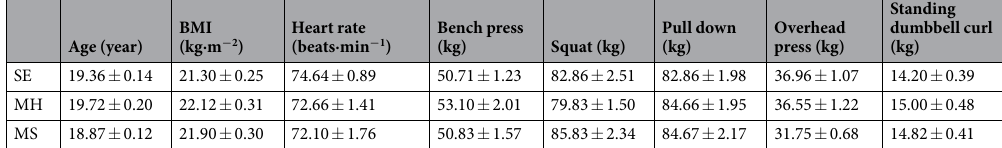
Table 1. Clinical characteristics of participants and absolute load (kilograms) used during the RT session. Values represent the mean ± SEM obtained from 15 subjects separately in each of the three